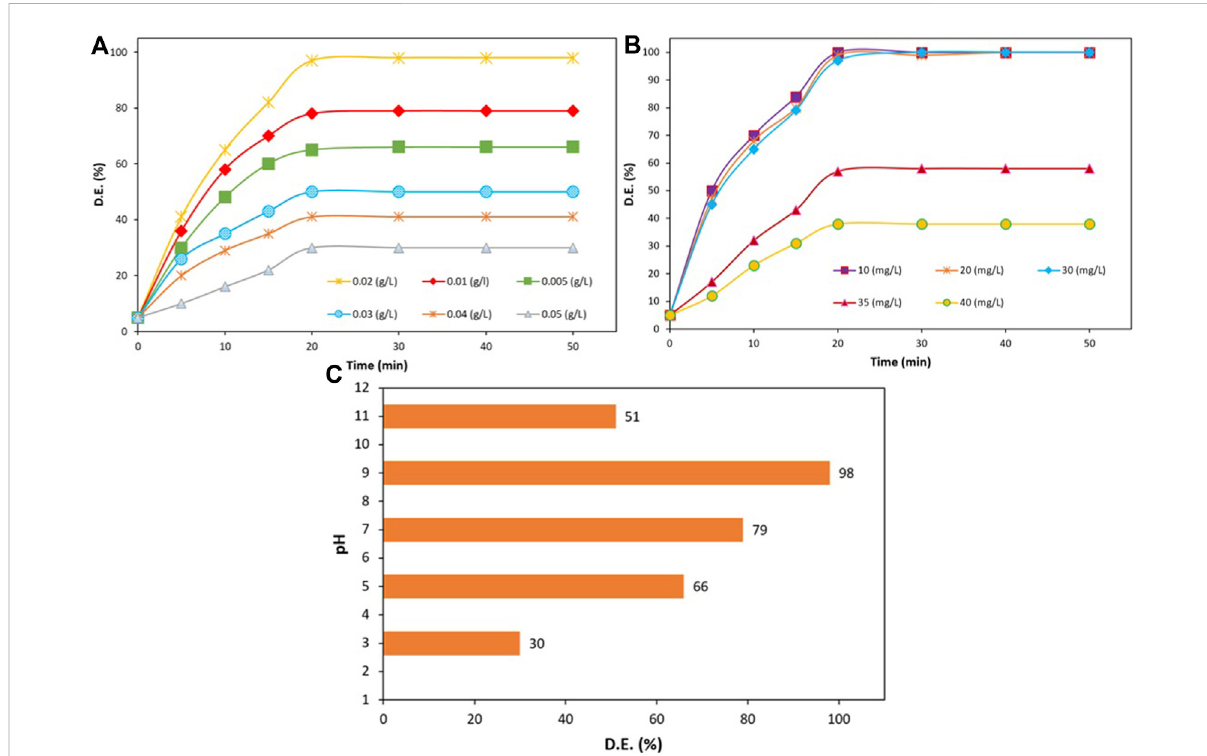
FIGURE 9 (A) The effect of photocatalyst amount on the ef fi ciency of the TC photodegradation (TC amount = 30 mg L − 1 , and pH = 9), (B) TC concentration effect on the progress of the photodegradation process (photocatalyst amount = 0.02 g L − 1 , and pH = 9), (C) The effect of pH on